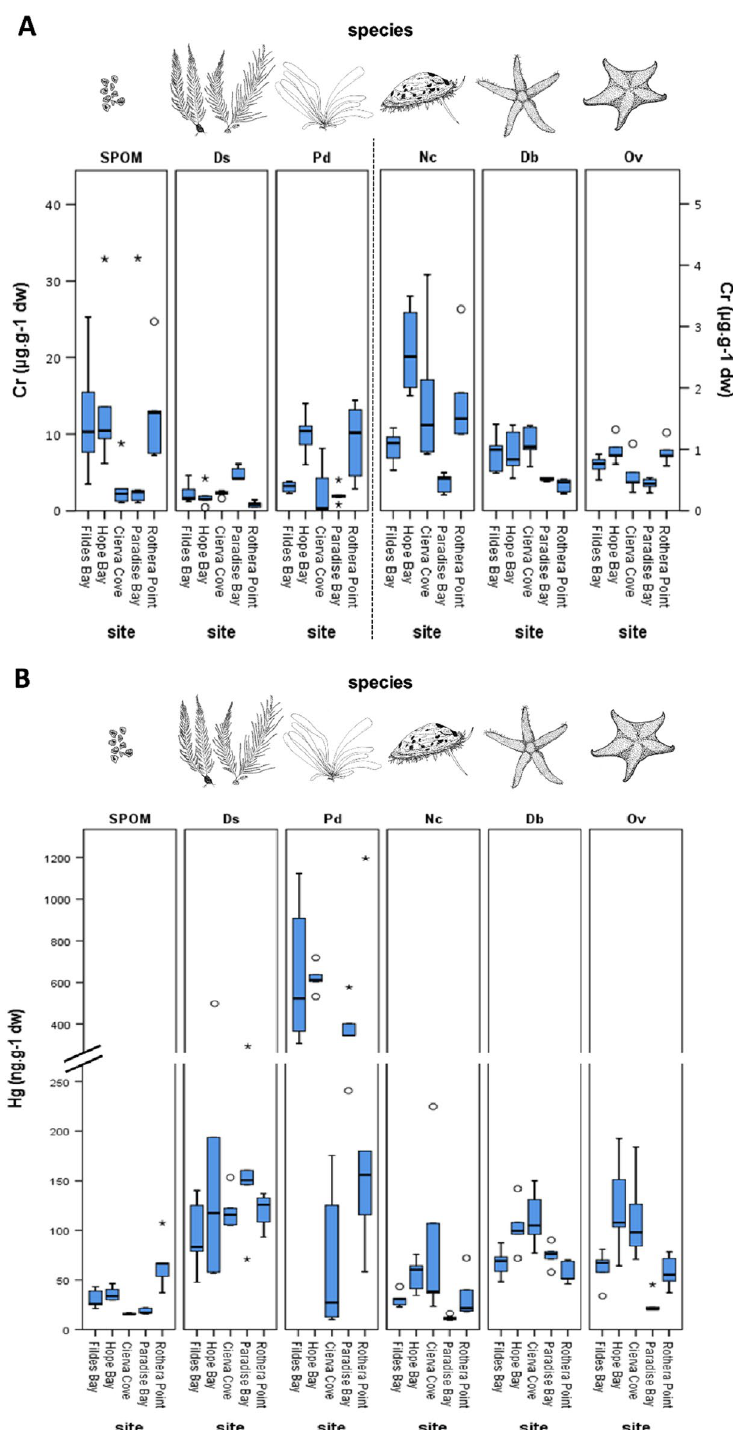
Figure 2. Concentration of Cr and Hg in the different sites and species studied along the Antarctic Peninsula. ( A ) Cr, values expressed as μg g-1 of dry weight. The values of Cr for the primary producers were much higher than the animal species, so they were represented separately and scale changed accordingly. ( B ) Hg, values expressed as ng g -1 of dry weight. Discontinuous Y-axis was used to facilitate visualization. Central lines show the mean, boxes extend to the 25th and 75th percentile, whiskers extend to 1.5 × IQR, dots and asterisks are outliers. SPOM Suspended Particulate Organic Matter, Ds Desmarestia spp., Pd Palmaria decipiens , Nc Nacella concinna , Db Diplasterias brucei , Ov Odontaster validus . The images of species were drawn by the authors of this